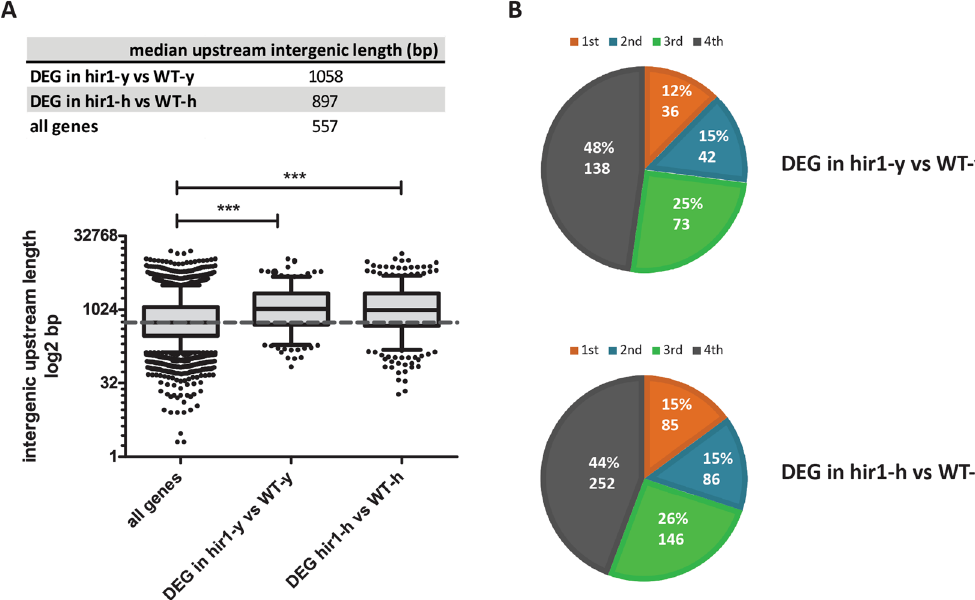
Figure 4. Hir1-affected genes harbor above-average intergenic upstream regions. ( A ) Intergenic upstream regions were extracted from the C . albicans genome assembly 22 and length distribution of those elements is displayed for all genes detected in the RNA-seq (all genes), for differentially expressed genes (DEGs) in hir1 ∆ / ∆ cells during yeast growth (hir1-y vs WT-y) and upon hyphal induction (hir1-h vs WT-h). Boxplot whiskers represent the 5–95 percentiles and the dotted line the median upstream intergenic length in “all genes”. Statistical analysis was carried out using Kruskal-Wallis with Dunn’s post hoc test. *** P < 0.001. ( B ) The “all genes” data set was split into quartiles based on the overall upstream intergenic length distribution. The relative gene number and the proportions (%) of DEGs in hir1-y vs WT-y and hir1-h vs WT-h in each quartile are displayed. ( A , B ) Differentially expressed genes were defined by an at least 1.5-fold change with an FDR value <